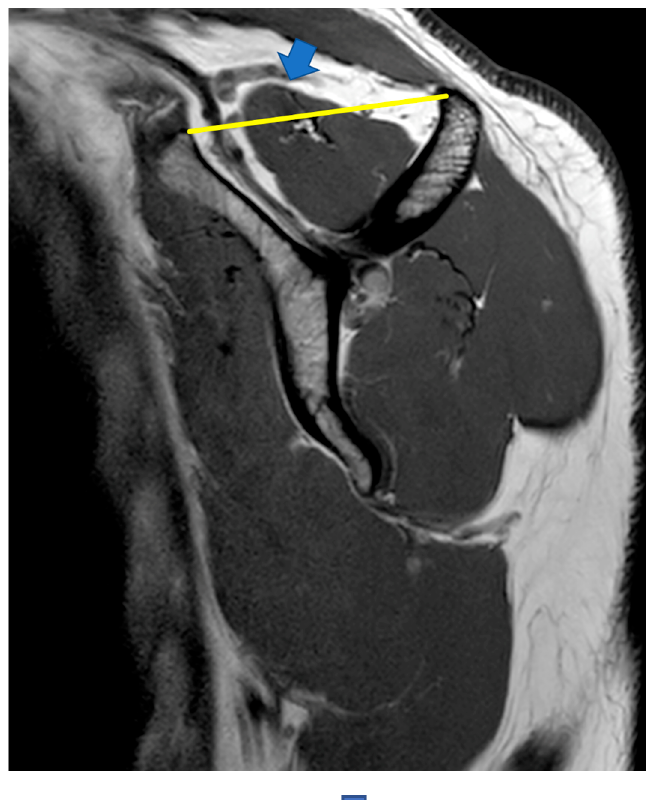
Figure 4. Negative tangent sign: indicates supraspinatus extending above the tangent.